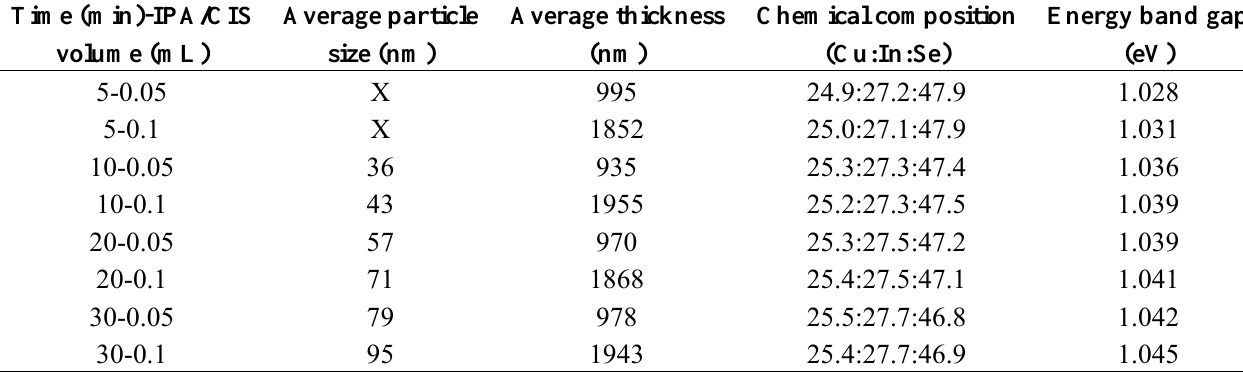
Table 1. Average particle sizes, average thickness, chemical composition, absorption coefficient, and energy band gap of the CuInSe (CIS) absorber layers as the functions of 2 annealing time and used volume of CIS isopropyl alcohol (IPA/CIS)